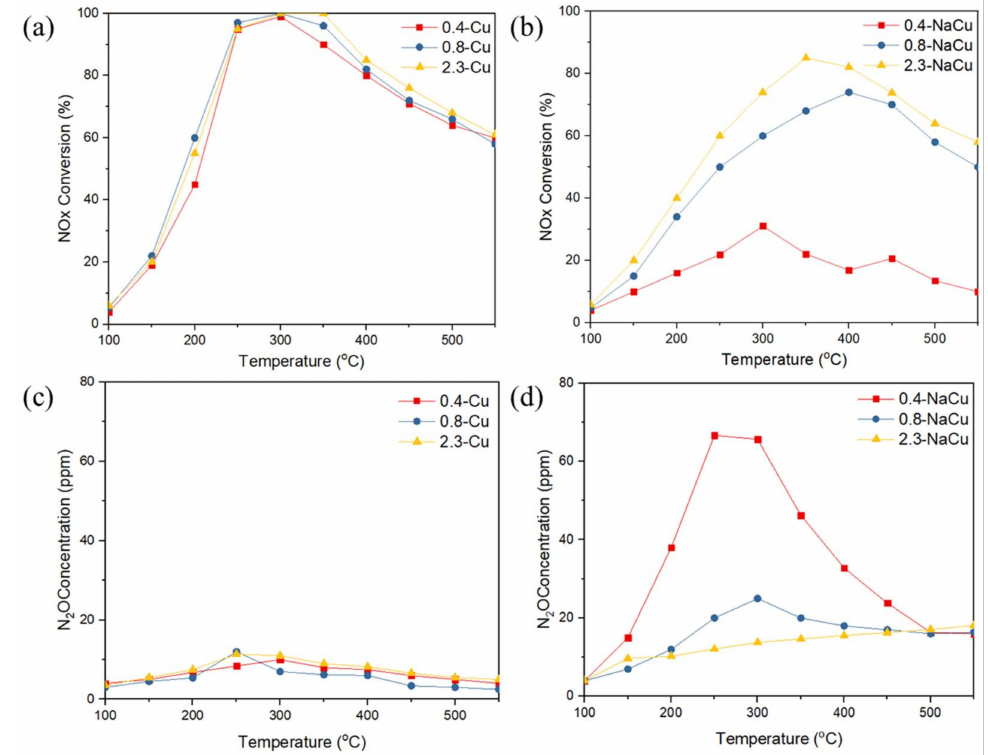
Figure 2. ( a , b ) NO x conversion and ( c , d ) N 2 O formation of Cu/SSZ-13 before and after Na poisoning. The gas feed contains 500 ppm NO x , 500 ppm NH 3 , 10% O 2 , 3% H 2 O, balanced N 2 . The gas hourly space velocity (GHSV) is 72,000 h − 1